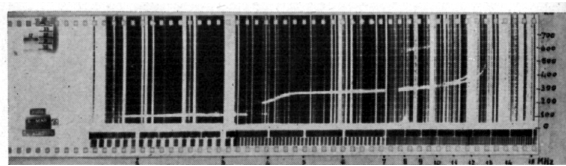
Fig. 4. Typical ionogram from S. Alessio observatory (Rome, 1958) (from: Istituto Nazionale di Geofisica, 1963).